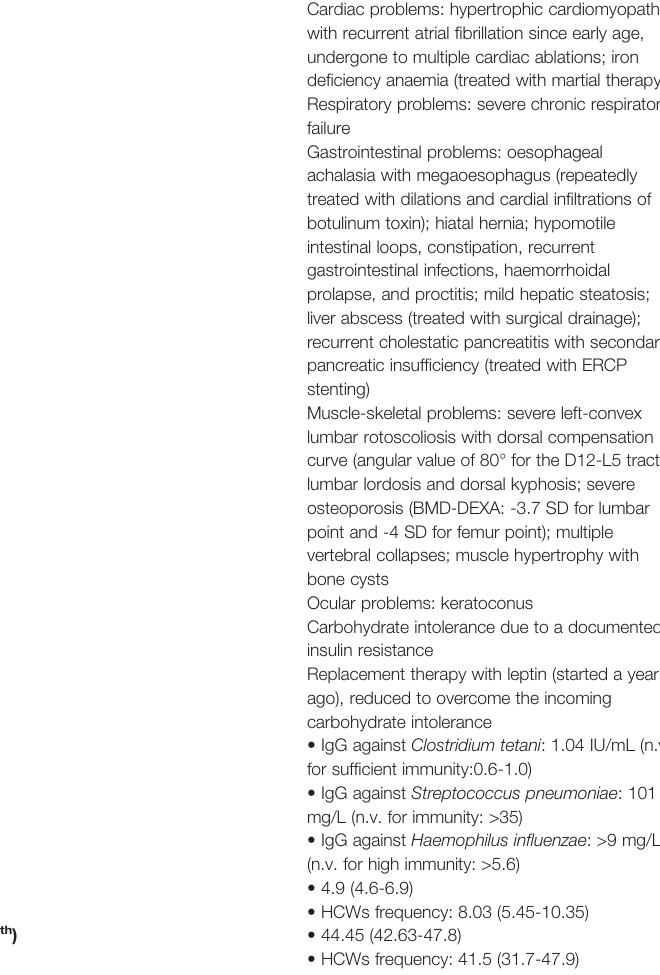
TABLE 1 | Clinical history and response to vaccinations. Pathological remote